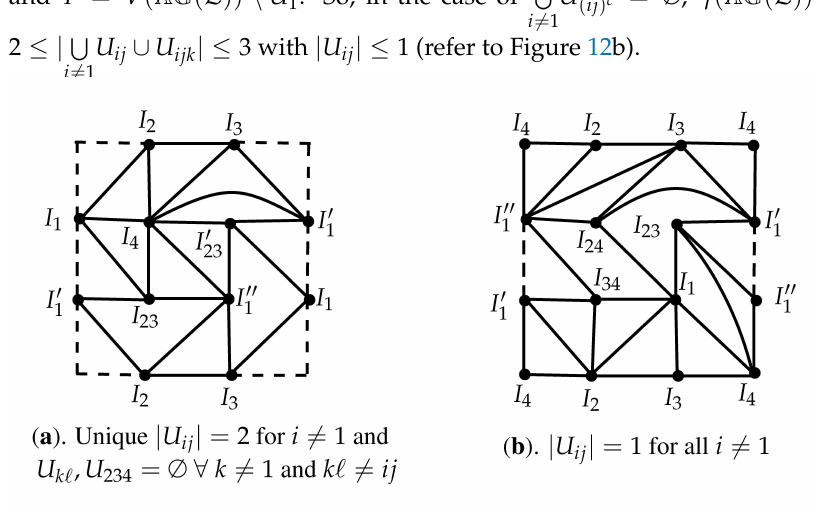
∪ 4 U n | = 6 with | U 1 | = n = 1